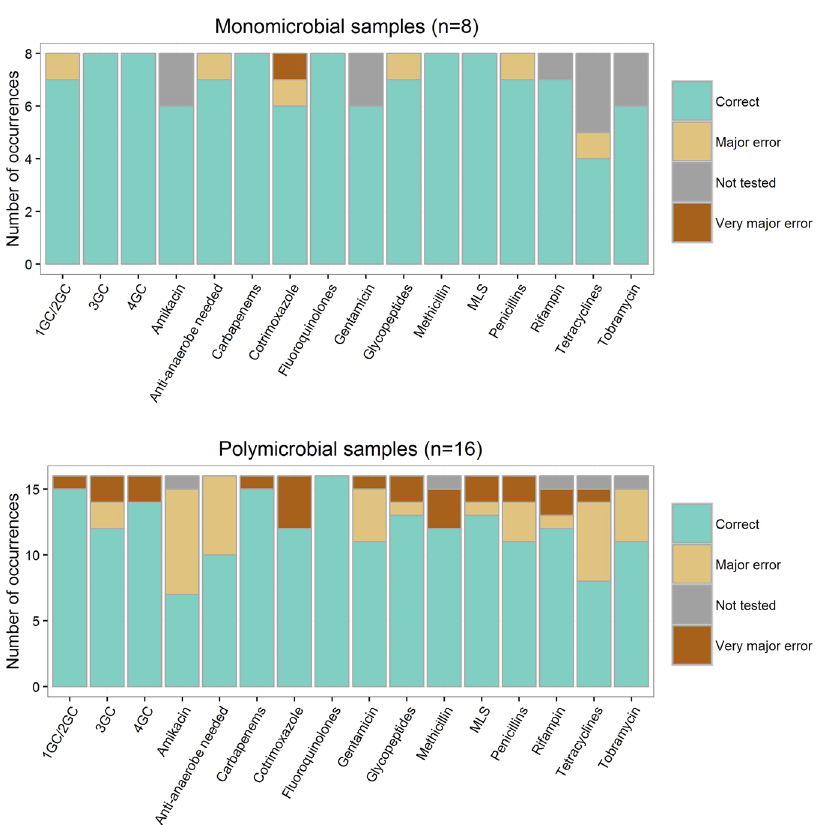
Figure 4. Antibiotic susceptibility inference from metagenomic data compared to culture and conventional antibiotic susceptibility testing (gold standard). 1GC/2GC, 3GC, 4GC: 1 st , 2 nd , 3 rd and 4 th generation cephalosporins, respectively. MLS: macrolides, lincosamides, streptogramines. Correct: metagenomic result consistent with the result given by conventional methods. Very major error: metagenomic data did not predict antibiotic resistance while at least one bacteria identified by conventional methods was resistant to this antibiotic. Major error: metagenomic data predicted antibiotic resistance while all the bacteria identified by conventional methods were susceptible. Not tested: no molecule from the antibiotic class was tested with conventional